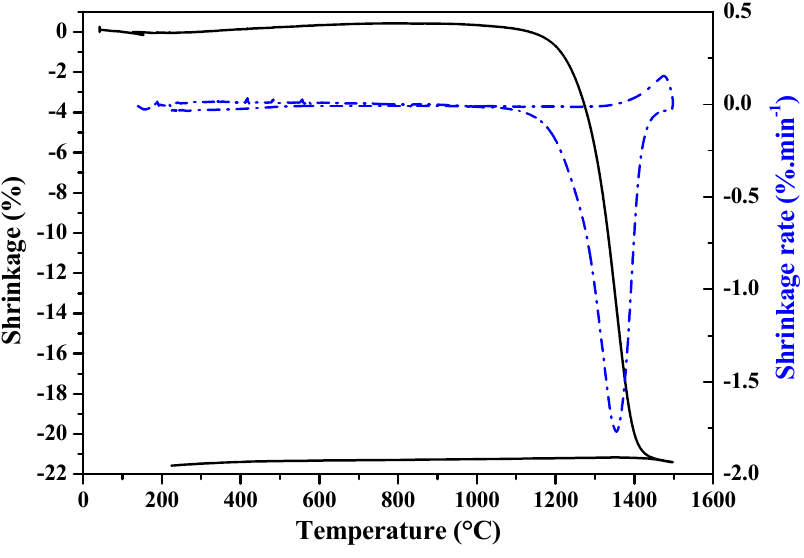
Figure 1. Shrinkage curve of a BCZN sample as a function of temperature.